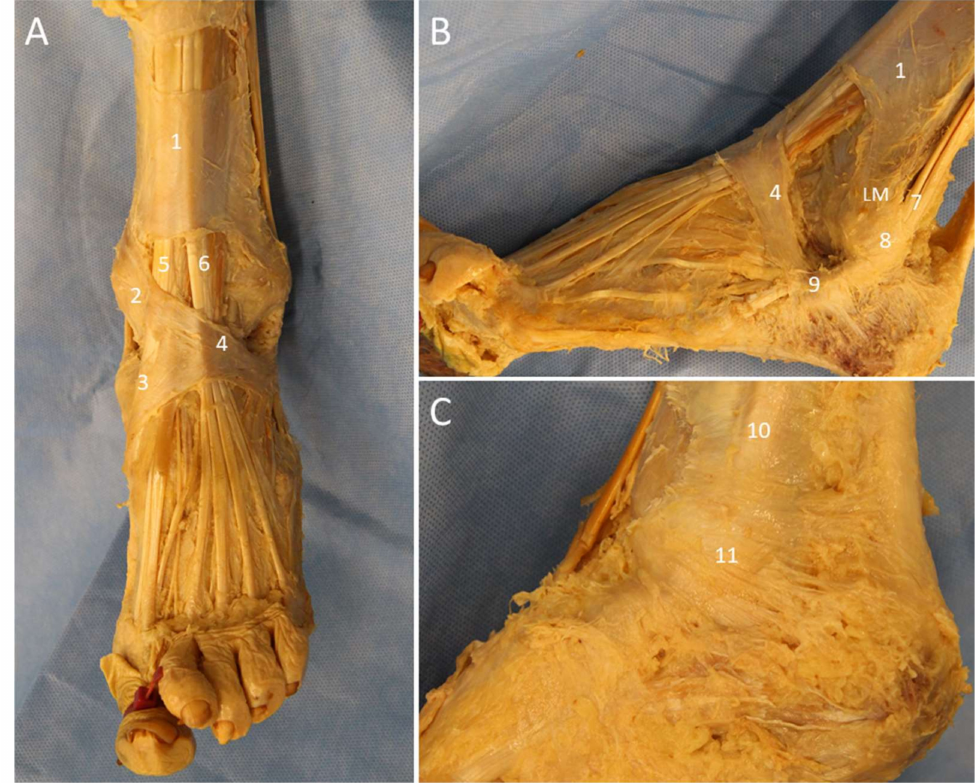
Figure 16. Cadaveric models of the extensor ( A ), peroneal ( B ), and flexor ( C ) retinacula. 1: superior extensor retinaculum; 2: oblique superomedial band of the inferior extensor retinaculum; 3: oblique inferomedial band of the inferior retinaculum; 4: frondiform ligament; 5: tibialis anterior tendon; 6: extensor digitorum longus; 7: peroneus longus and brevis tendons; 8: superior peroneal retinaculum; 9: inferior peroneal retinaculum; 10: tibialis posterior tendon; 11: flexor retinaculum; LM: lateral